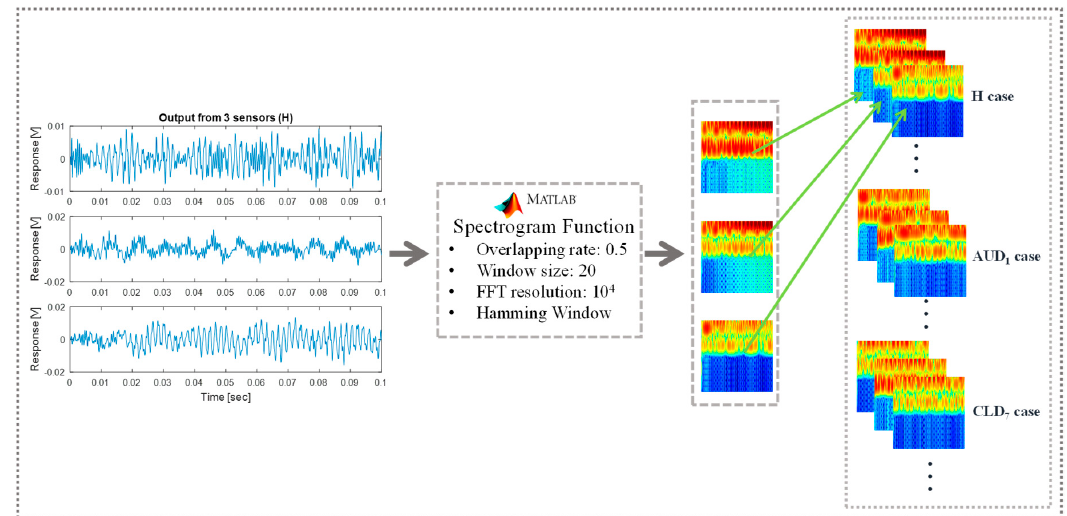
Figure 4. Preparation of vibration-based spectrograms for deep learning using the spectrogram function of Matlab.